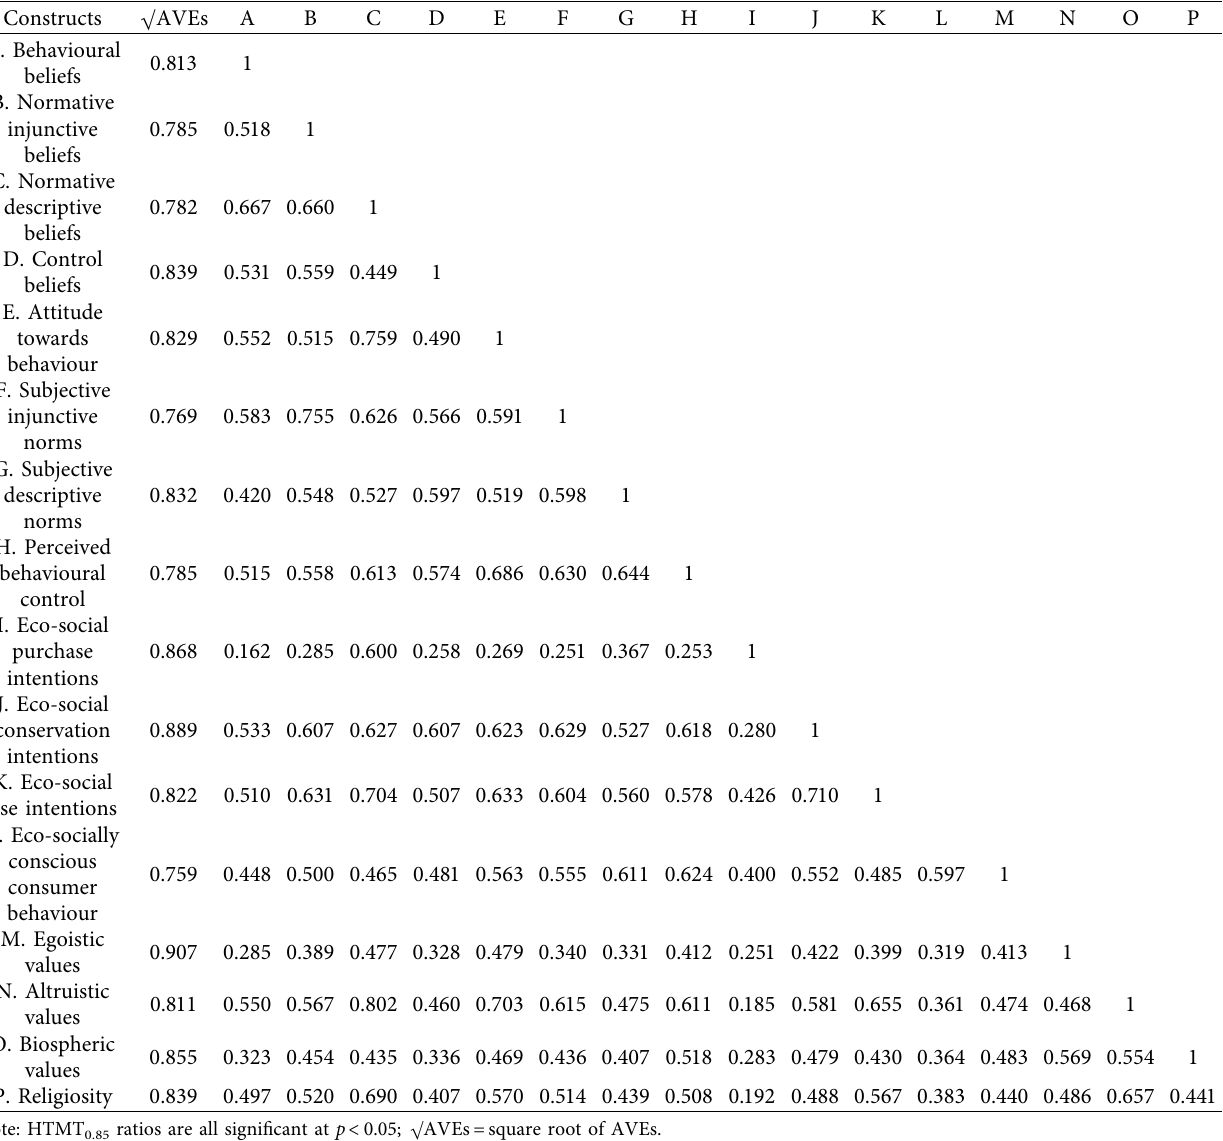
Table 4: HTMT 0.85 ratios and square root of